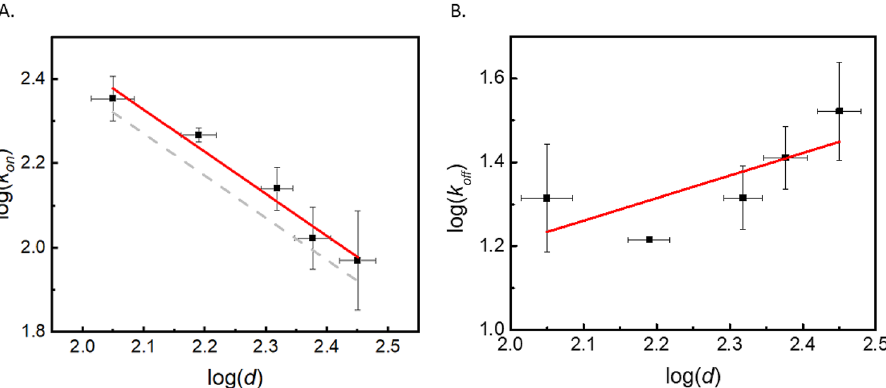
Figure 3. Relation of k on and k off with the average diameter ( d ) of the LUVs. In both panels, d was determined through dynamic light scattering measurements. (A) The relation between log( k on ) and log( d ), shows a negative linear dependence. The slope of the linear fitting (red solid trend line) is −1.00 ± 0.10. The grey dashed line represents a theoretical estimate according to diffusion constant estimates and Eq. (8). (B) log( k off ) shows a positive dependence on log( d ). The slope of the linear fit is 0.54 ± 0.28. Error bars of log( d ) are from the size distribution of each sample determined by DLS. k on and k off were obtained by averaging the fitting results obtained via Eq. (3) from three different vesicle preparations, the results for a representative single one of these are shown in Fig. 2B. The error bars for log( k on ) and log( k off ) are the standard deviations from three different vesicle